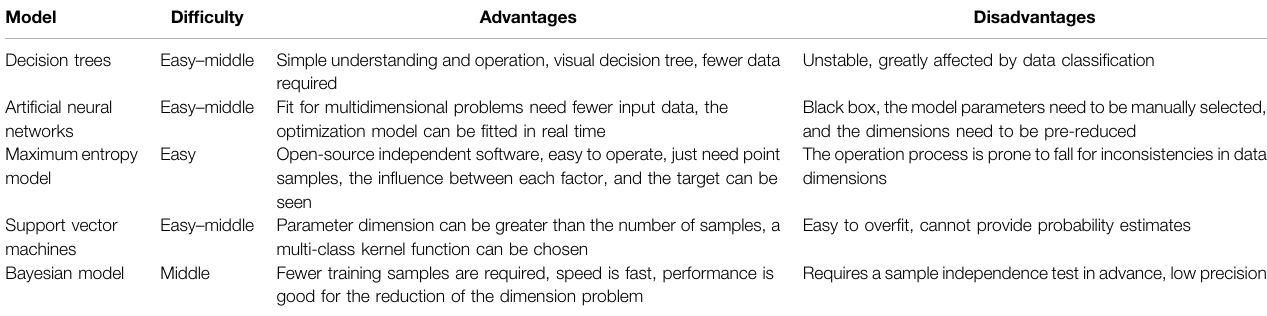
TABLE 1 | Advantages and disadvantages of common machine learning modes in landslide susceptibility